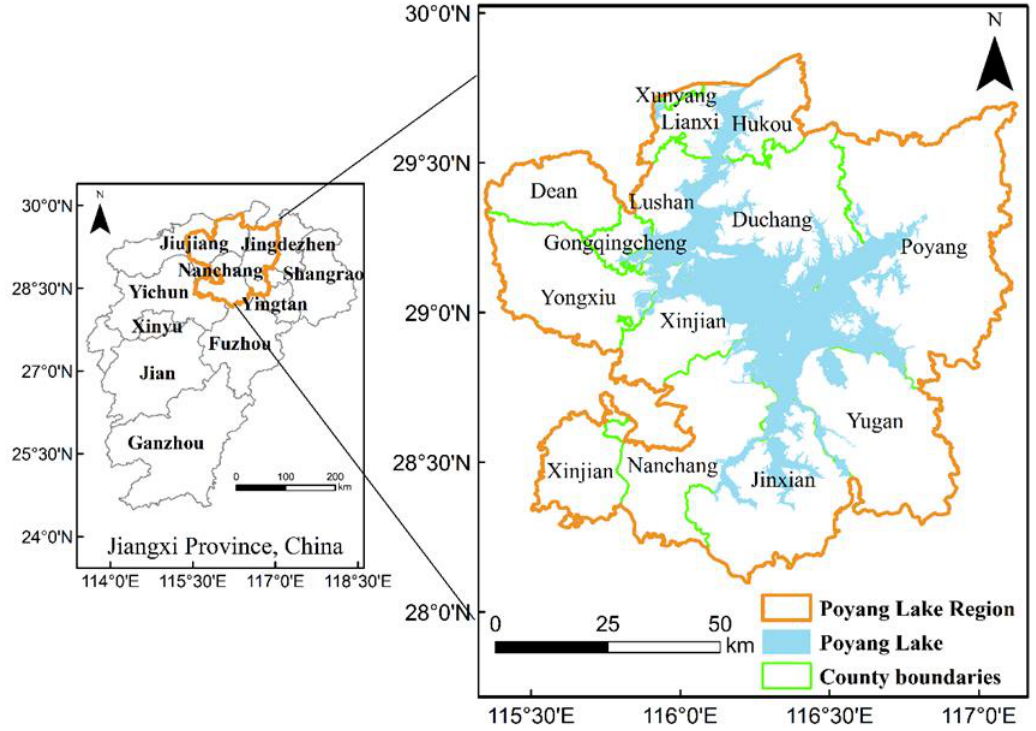
Figure 1. Geographical location of Poyang Lake Region.